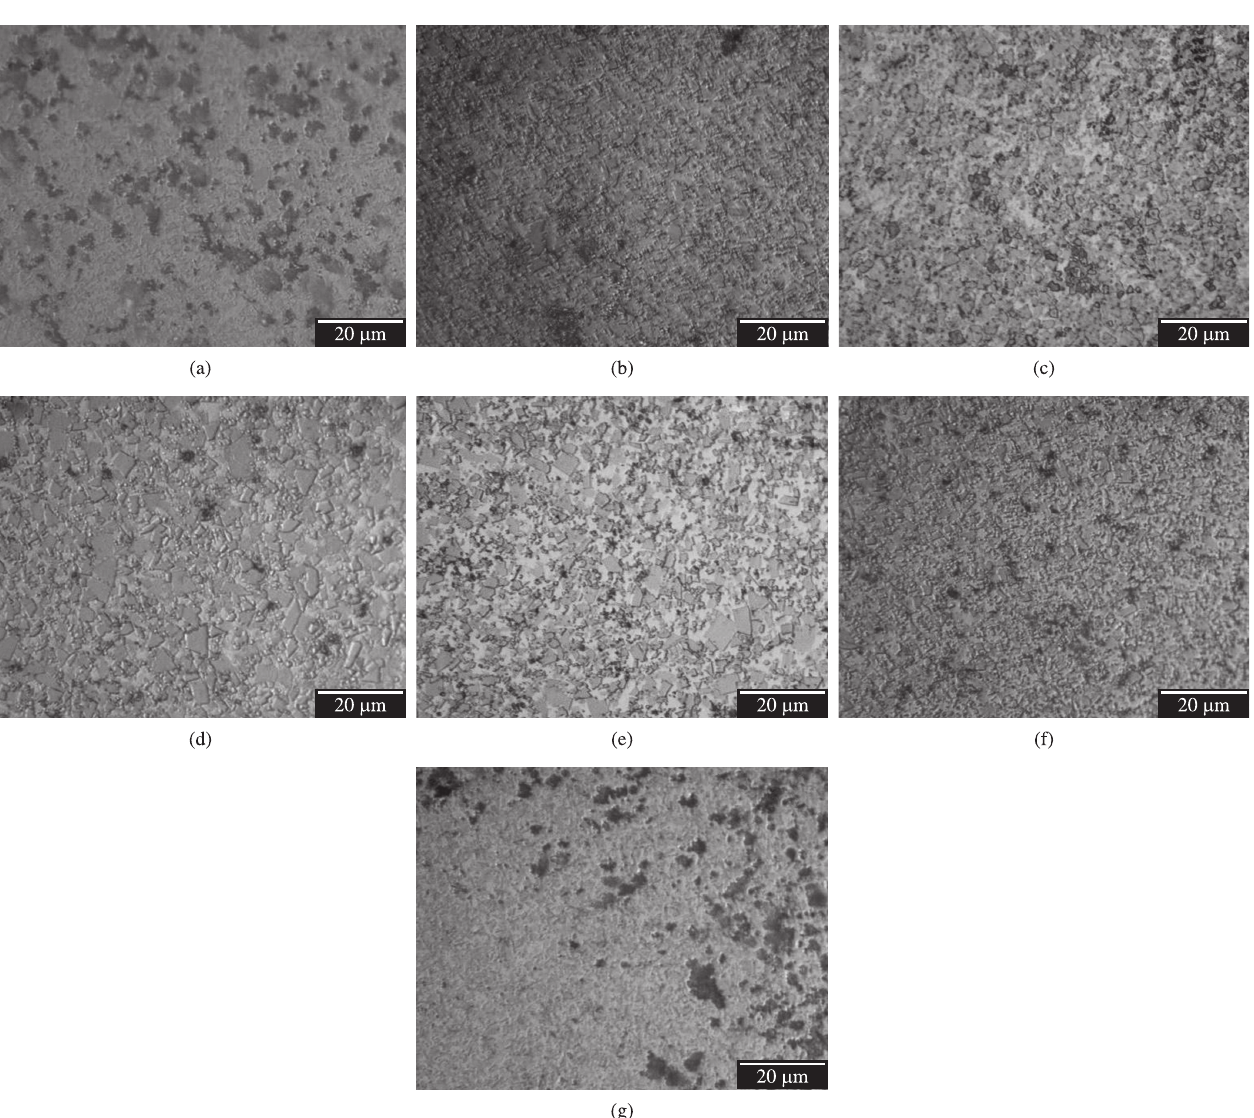
Figure 11. SEM micrographs of sintered samples prepared from powder ball milled for: a) 1 hour; b) 2 hours; c) 4 hours; d) 8 hours; e) 16 hours; f) 32 hours; and g) 64 hours. 1000× magnification, Murakami’s